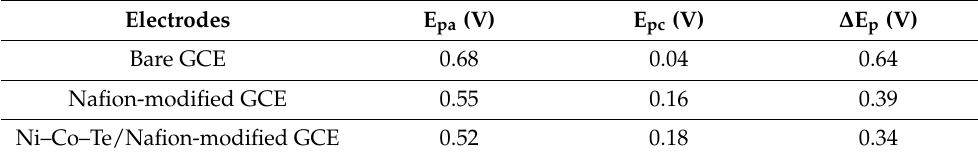
Figure 4. CV curves of bare GCE (black line), Nafion-modified GCE (blue line), and Ni–Co–Te/Nafion-modified GCE (red line) in 0.1 M PBS (pH = 7.0) in the absence (dashed lines) and presence (solid lines) of 1 mM acetaminophen at a scan rate of 50 mV s − 1 . Table 1. The anodic/cathodic peak potentials (E pa and E pc ) and peak-to-peak separation values ( ∆ E p ) of the electrodes in the presence of 1 mM